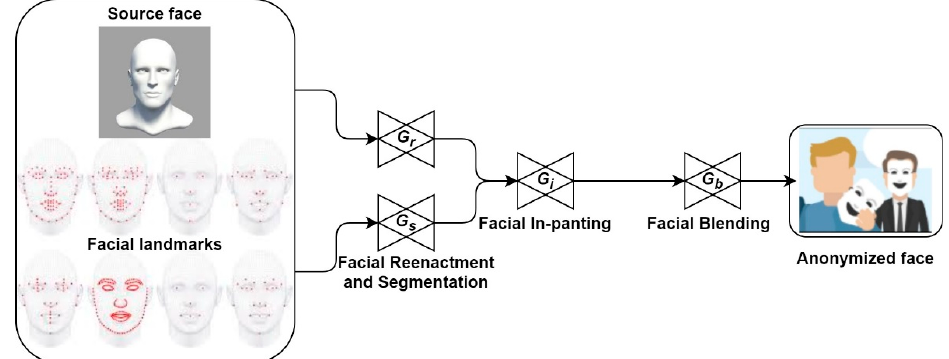
Figure 10. Illustration of facial anonymization for facial privacy preservation. It is required during monitoring of the suspect under an irregular situation.